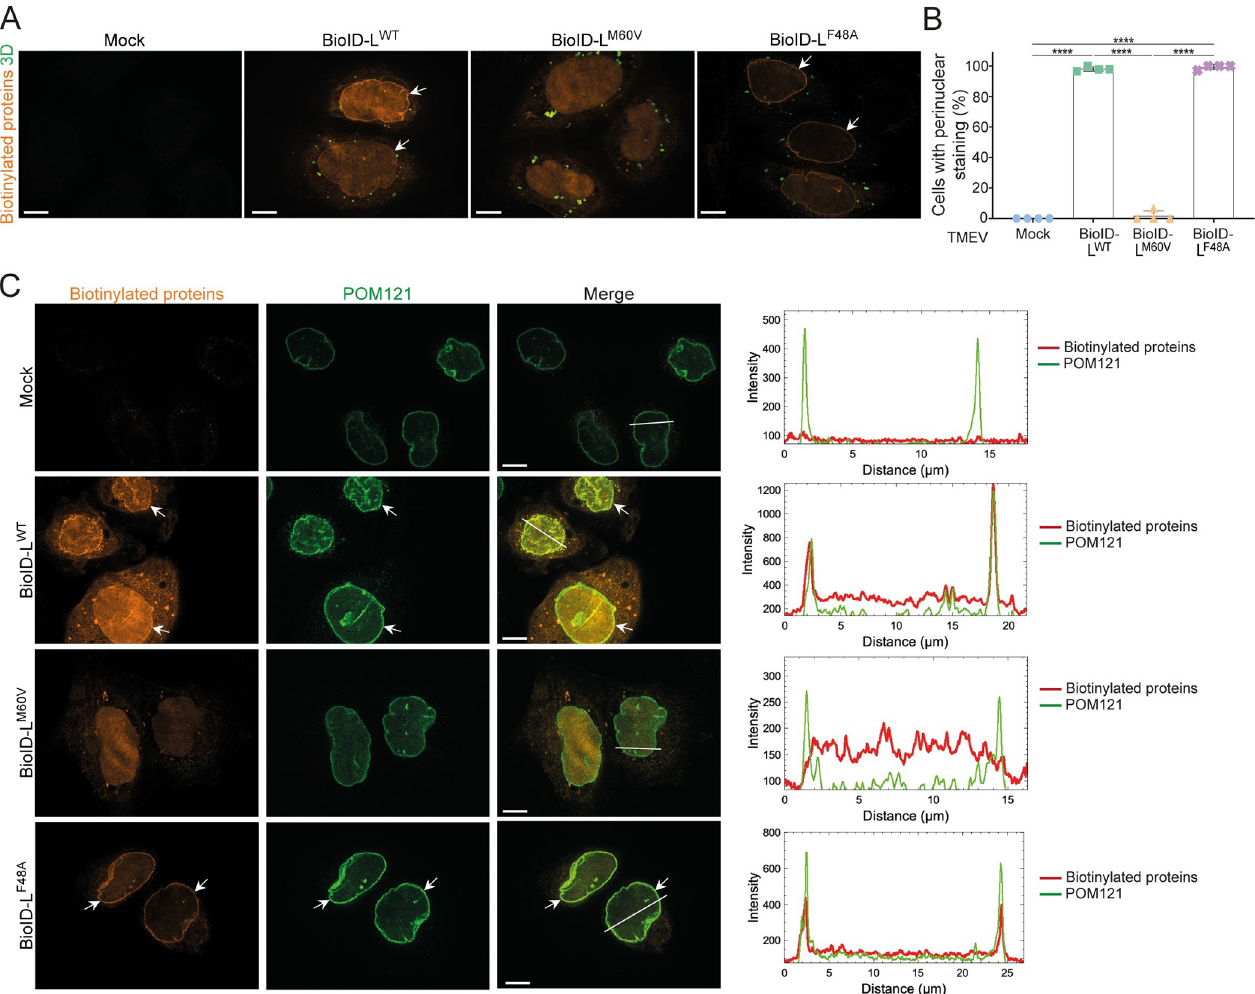
Fig 8. Subcellular localization of proteins biotinylated by BioID-L. (A) Confocal microscopy images of biotinylated proteins stained with streptavidin-Alexa Fluor 594 (orange) and 3D viral polymerase (green) in HeLa cells infected for 10h with BioID-L WT , BioID-L M60V or BioID-L F48A replicons (MOI 5). 3D viral polymerase was stained as a control of infection. (B) Quantification of nuclear rim staining in HeLa cells infected with BioID-L WT , BioID-L M60V or BioID- L F48A viruses (mean ± SD). Counts: 31 ± 11 infected cells per experiment (n = 4). One-way ANOVA was used to compare all samples with each other. Significant differences are shown. (C) BioID-L biotinylates proteins that colocalize with the FG-NUP POM121. Confocal microscopy images and intensity vs distance plots of biotinylated proteins (orange) and POM121 (green) in HeLa cells infected with BioID-L WT , BioID-L M60V or BioID-L F48A viruses for 10h (MOI 5). White arrows point to examples of cells exhibiting a nuclear rim staining. Scale bar: 10 μ